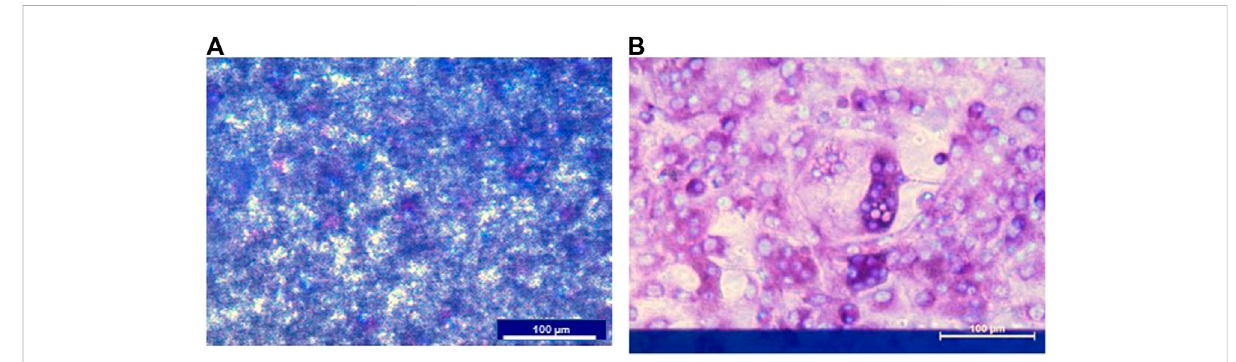
ECIS plate with CAP coating and mouse bone marrow cells cultured with M-CSF or M-CSF and RANKL. (A) Cells were cultured on an ECIS plate withCAPfor11 dayswithonlyM-CSF.Noosteoclastswereformed,andtheCAPcoatingisnotlysed.Nucleiofthemononucleatedcellswerestained withDAPI(blue). (B) .Whenculturedfor 11 dayswith M-CSFandRANKLmultinucleated andTRAcP(purple),positiveosteoclastswereformed.Nuclei stained with DAPI (blue). The blue horizontal bar in B is the ECIS plate electrode.